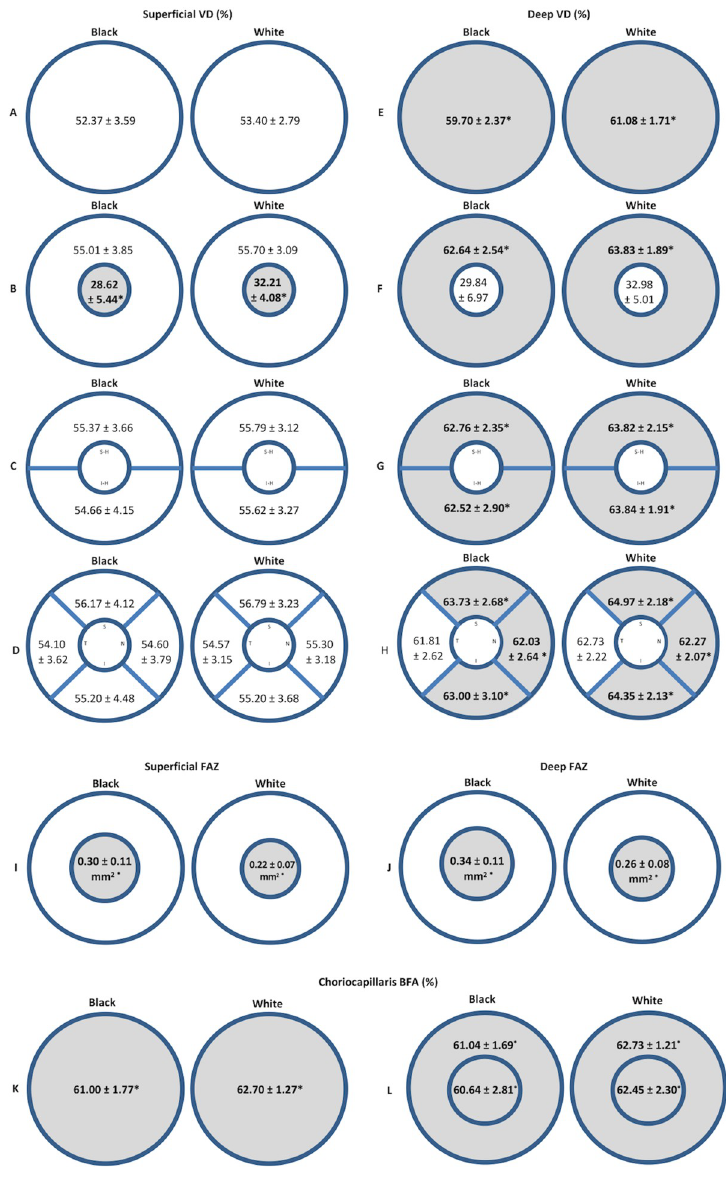
Fig 2. Representative maps of mean VD (A-D) and FAZ (E) in the SCP and DCP, and BFA (F) in the choriocapillaris for both subject groups. Data are presented as means ± standard deviation. Portions of the map shaded in gray represent areas where there was a statistically significant difference between the two subject groups. Maps representing the VD in the 3x3mm area of the macular image (A), parafovea and fovea (B), superior and inferior hemifields (C), and parafoveal quadrants (D). Maps representing the area of FAZ in the SCP and DCP (E). VD = vessel density (%), FAZ = foveal avascular zone (mm 2 ), BFA = blood flow area (%), SCP = superficial capillary plexus, DCP = deep capillary plexus, S-H = superior hemifield, I-H = inferior hemifield, S = superior, N = nasal, I = inferior, T = temporal. � p < 0.05, linear mixed models. See Table 1 for corresponding p values. parafovea was divided into quadrants and superior and inferior hemifields, there was no sig- nificant difference between the study groups (p = 0.590, p = 0.292, respectively). In the region of the macula analyzed in the 3x3mm scan including both fovea and parafovea, there was no significant difference in the VD (52.37 ± 3.59% vs 53.40 ± 2.79%, p = 0.177).